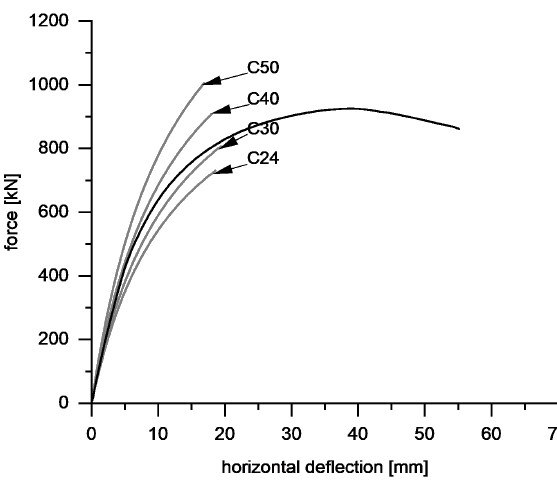
Figure 12. Force-horizontal deflection calculated (gray) and experiment (black).